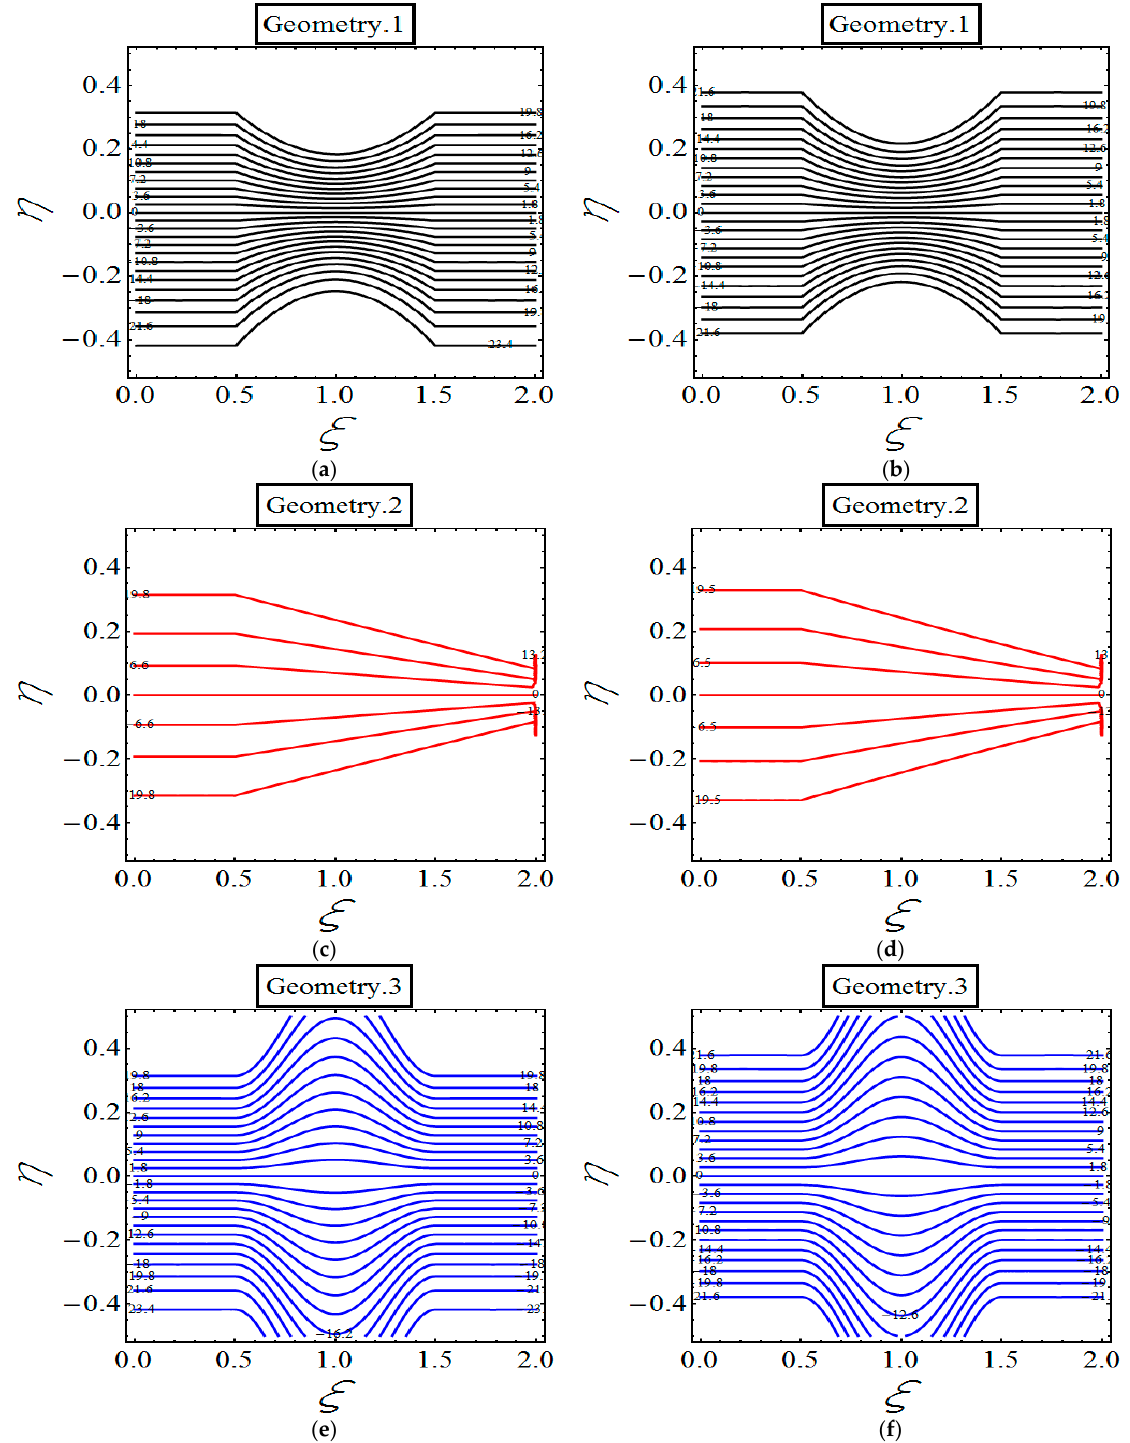
Figure 10. Stream lines for various Hartmann numbers M = 2 ( a , c , e ) and M = 5 ( b , d , f ) in three geometries.